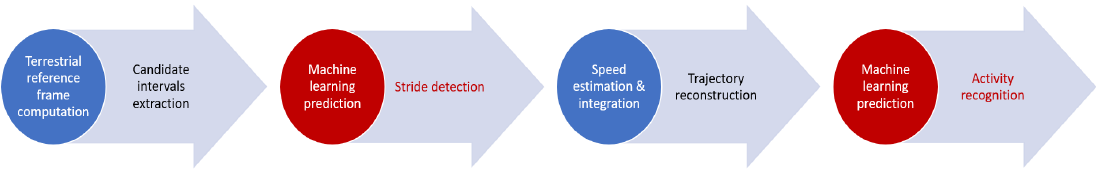
Figure 1. Our approach for trajectory reconstruction and human activity recognition (HAR) is based on stride